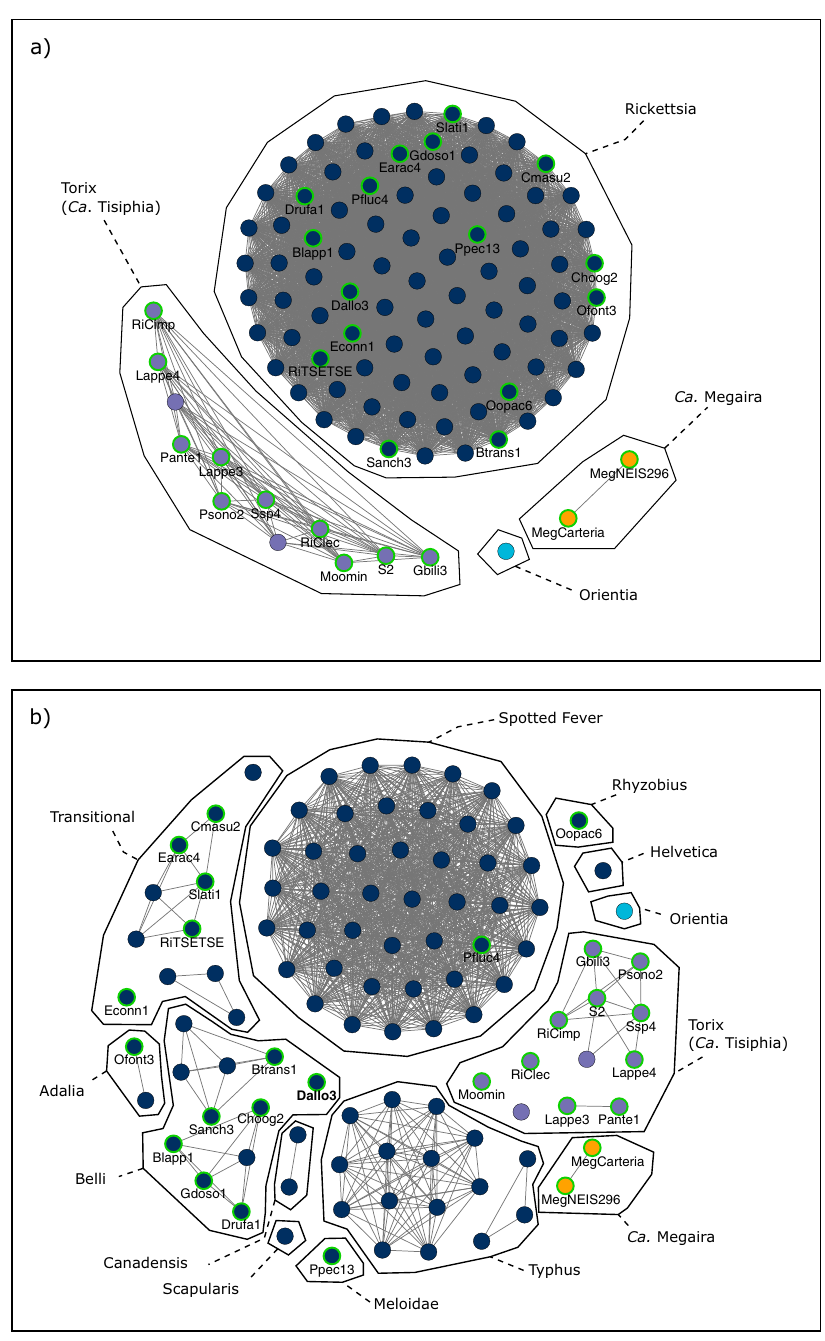
Fig. 2 Genus and species level clustering across Rickettsia and ‘ Ca . Megaira ’ . Frutcherman Reingold networks of pairwise ( a ) Average Amino Acid Identity (AAI) with edge weights >65% similarity and ( b ) Average Nucleotide Identity (ANI) with edge weights >95% similarity across all genomes. AAI and ANI illustrate genus and species boundaries, respectively. The 13 current cluster names are annotated over the 23 species clusters found in the ANI network. New genomes are named and have a green outline. Node fi ll colours indicate Rickettsia (Dark blue), ‘ Ca . Megaira ’ (orange), Torix/ ‘ Ca . Tisiphia ’ (purple), Orientia outgroup (light blue). Source data are provided in Source